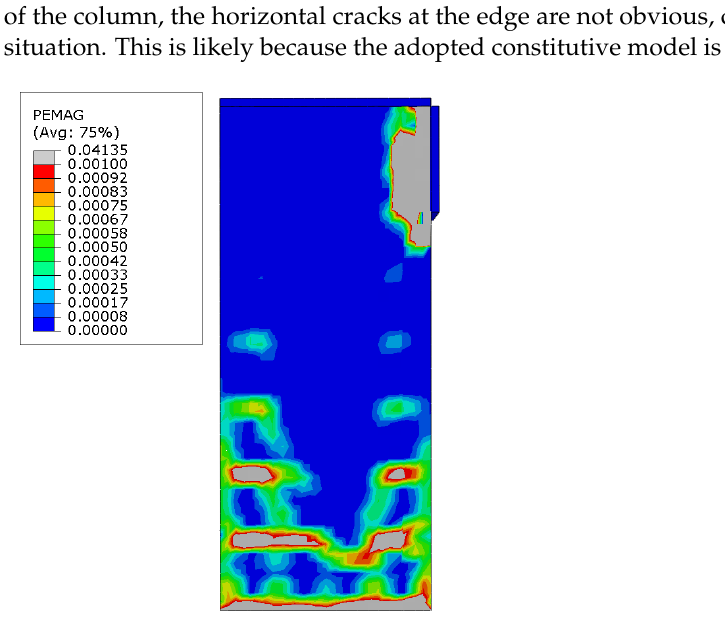
Figure 15. Equivalent Plastic Strain Diagram of SRCZ-1.